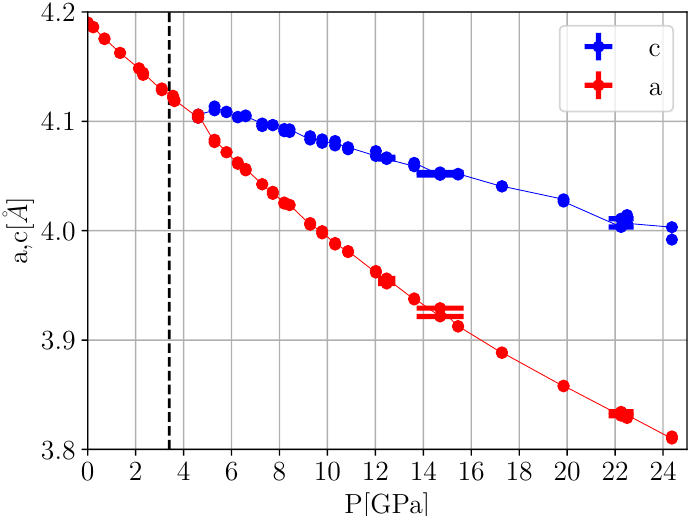
Figure 4. Pseudo-/cubic lattice constants of KMF under pressure at room temperature as measured in Ref. [11] with X-ray scattering. The transition pressure estimate P s ≈ 3.4 GPa put forward in Ref. [11], which is indicated by the dashed vertical line, is clearly too